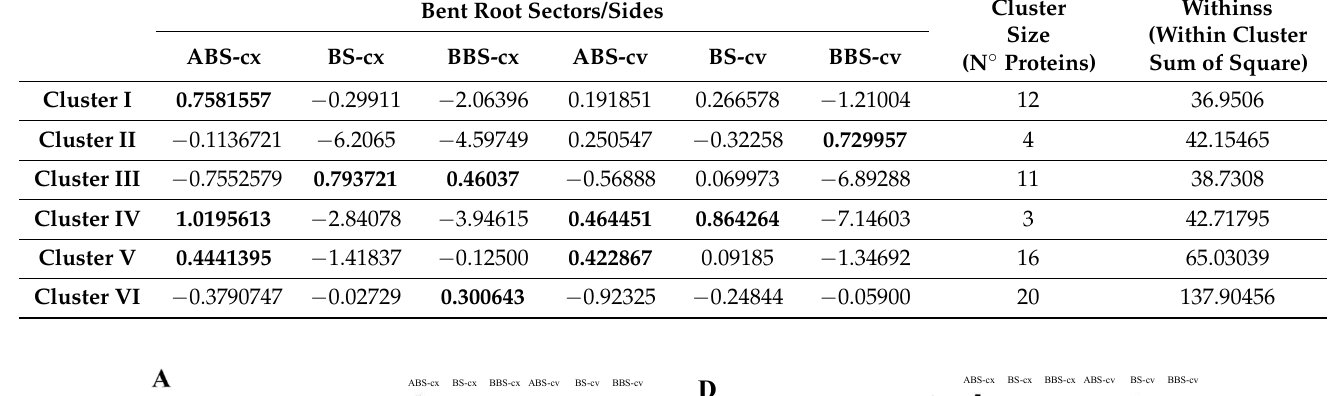
Table 1. k-means analysis. The 66 protein spots, which are differentially represented in poplar bent root, are grouped by k-means analysis in six main clusters (I–VI), characterizing one or more bent root sectors and sides. Sector-specific clusters are determined by using a score ≥ 0.3 (in bold) and the related proteins were used in the following subnetwork identification. ABS, above bending sector; BS, bending sector; BBS, below bending sector; cx, convex side; cv, concave side. Bent Root Sectors/Sides Cluster